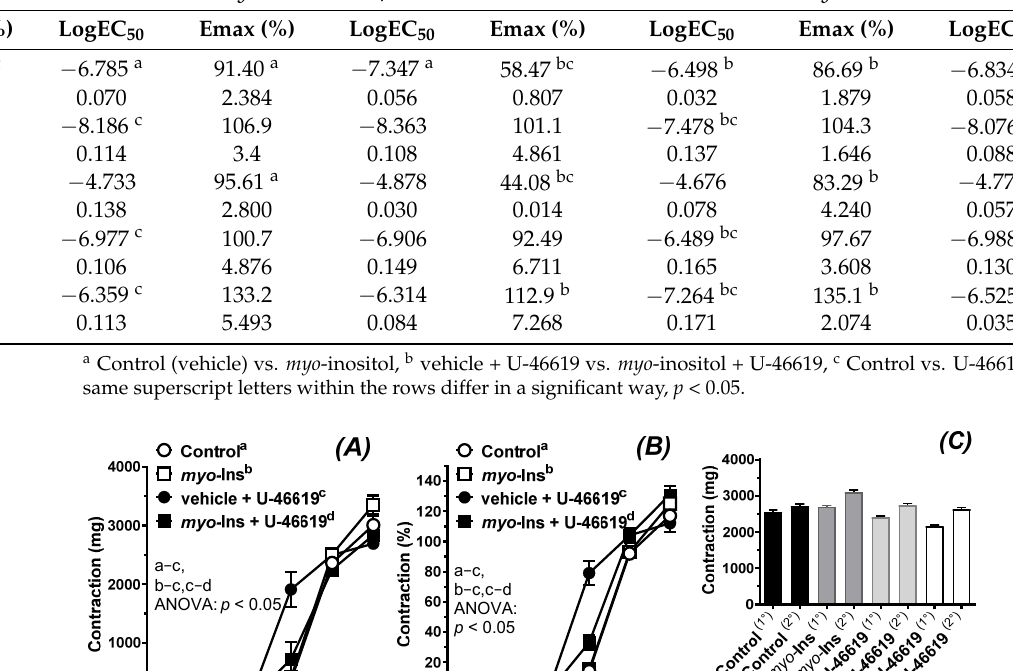
Table 1. Vascular response to the vasodilators: acetylcholine (ACh), sodium nitroprusside (SNP), CO releasing molecule (CORM-2), pinacidil, and the vasoconstrictor noradrenaline (NA).